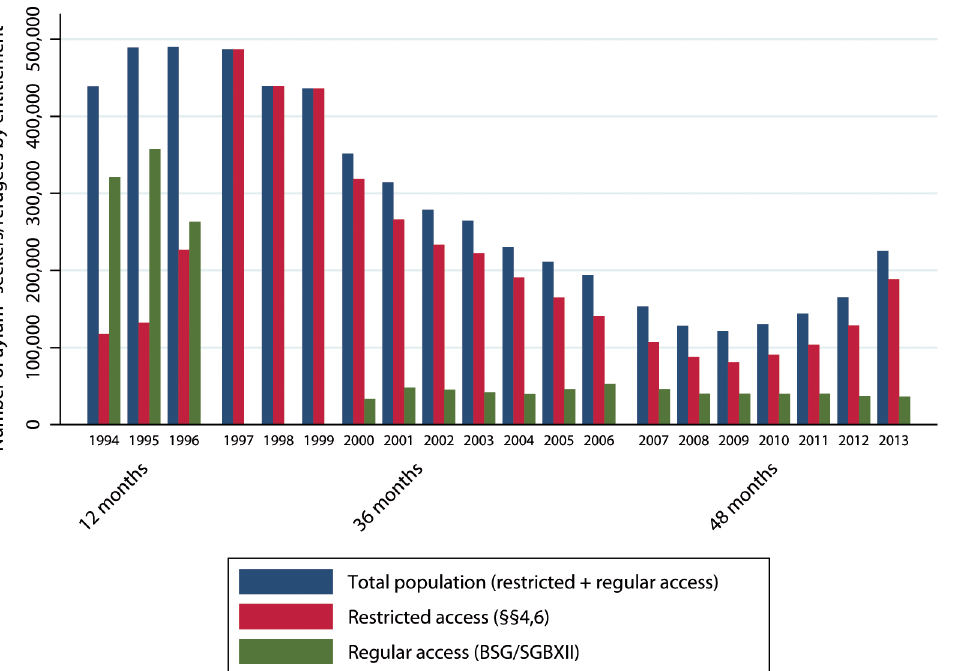
Fig 3. Population of asylum-seekers and refugees in Germany by entitlement of access to health care (1994 – 2013). Y-axis: shows the total number of asylum-seekers/refugees registered in Germany on 31 December of each year. Restricted access: refers to access to health care according to sections 4 and 6 of the Asylum-Seekers ’ Benefits Act (AsylbLG §§4,6). Regular access: refers to access to health care analogously to the general population according to the Federal Social Security Act (Bundessozialhilfegesetz, BSG) before 2005 and to Volume 12 of the Social Insurance Code ( Leistungen nach dem 5 . -9 . Kapitel SGB XII ) thereafter. 12/36/48 months: indicate the “ waiting time ” to regular access (according to section 2 of the Asylum-Seekers ’ Benefits Act, AsylbLG §2) in respective time periods.